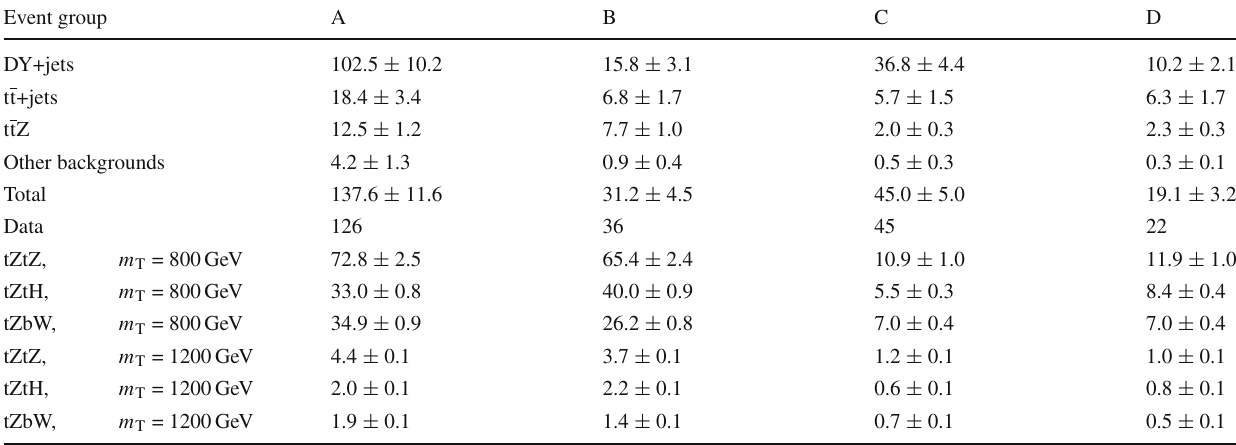
Table 7 The number of observed events and the predicted number of SM background events in the TT search using Z → μ + μ − channel in the four event groups. The expected numbers of signal events for T quark masses of 800 and 1200GeV for three different decay scenar- ios with assumed branching fractions B ( T → tZ ) = 100% (tZtZ)